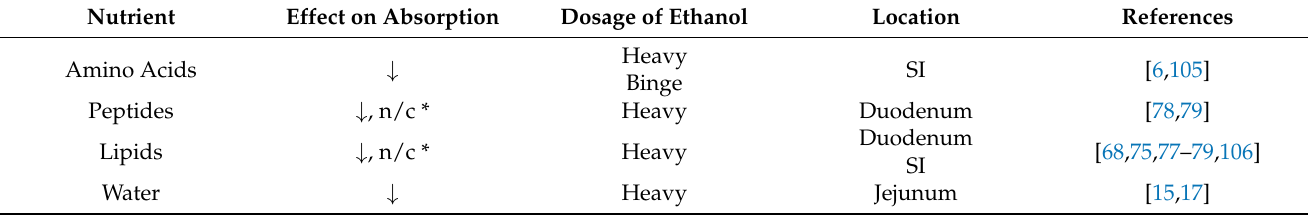
Table 1. The Effect of Ethanol on Macronutrient Intestinal Nutrient Absorption.